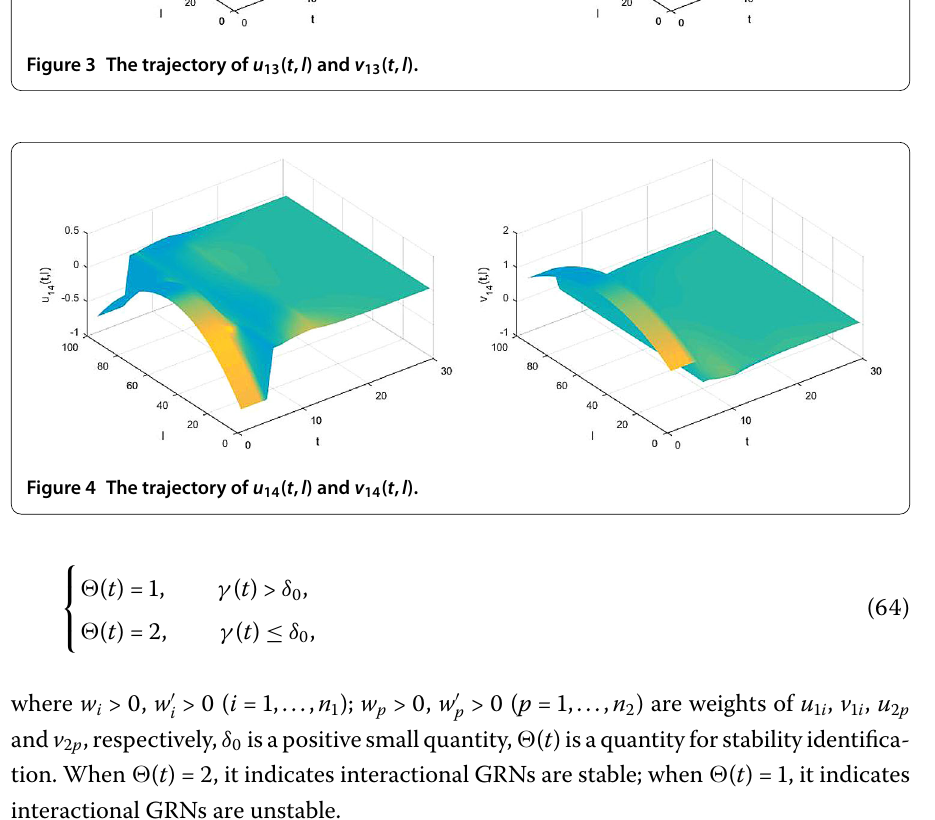
interactional GRNs are